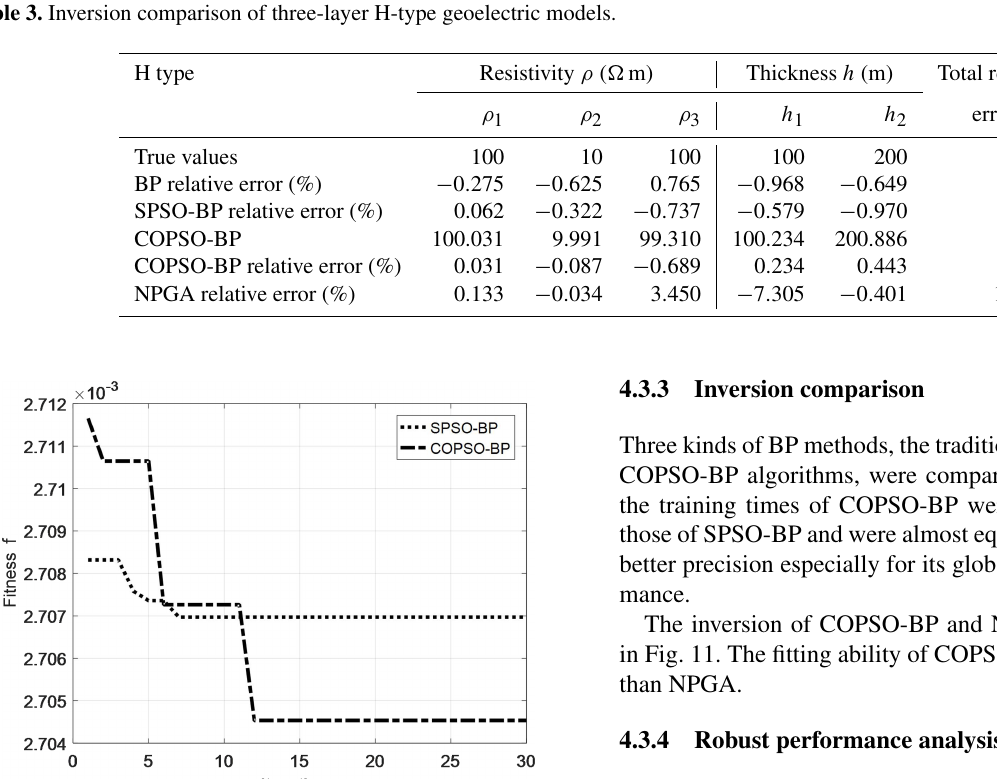
1000 group training samples were generated within the above ranges. The inversion results were shown in Table 4 and Figs. 9–10. It can be seen that the COPSO-BP algorithm has better global optimization